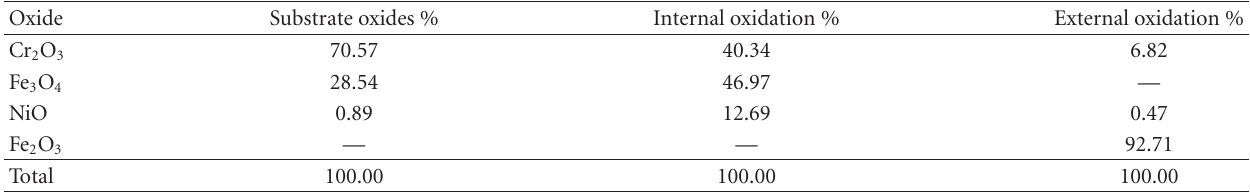
Table 4: EDX spectra analysis of the oxides in di ff erent areas for AISI 304 at T = 1000 ◦ C.